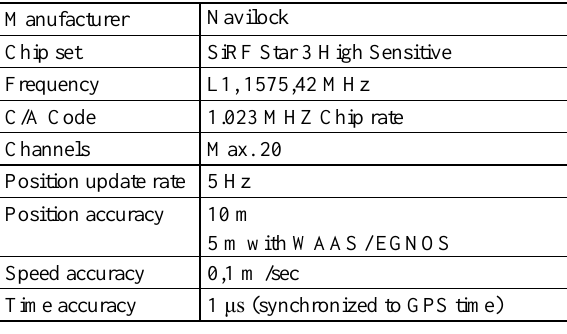
Table 4: GPS receiver technical specifications